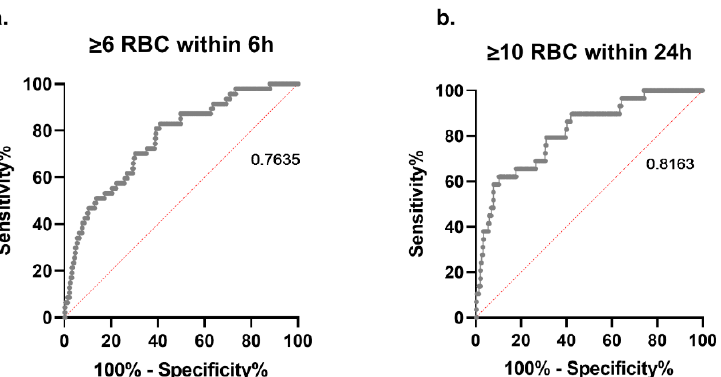
Figure 4. Receiver operating characteristic curve with corresponding area under the curve for serum IL-6 levels ≥ 350 pg/mL, and massive transfusion within ( a ) the first 6 h ( ≥ 6 RBCs) and ( b ) 24 h ( ≥ 10 RBCs) upon emergency room admission. Table 3. Massive transfusion prediction of IL-6 >350 pg/mL.